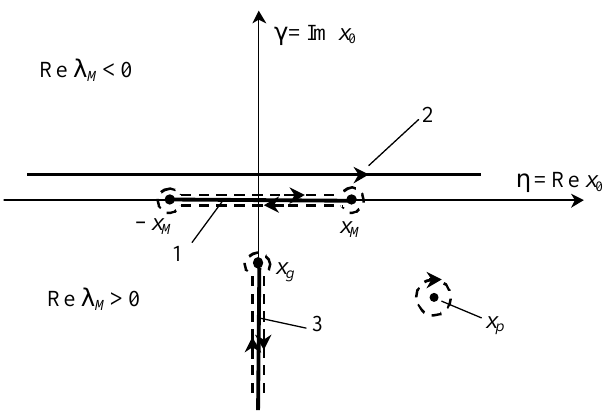
Fig. 2. A sketch of a complex x 0 plane. 1 – a cut in the complex plane that connects the bifurcation points of λ M . 2 – an integration path for the inverse Fourier transform. 3 – a cut for æ. One of the poles of the integrand is shown with x p